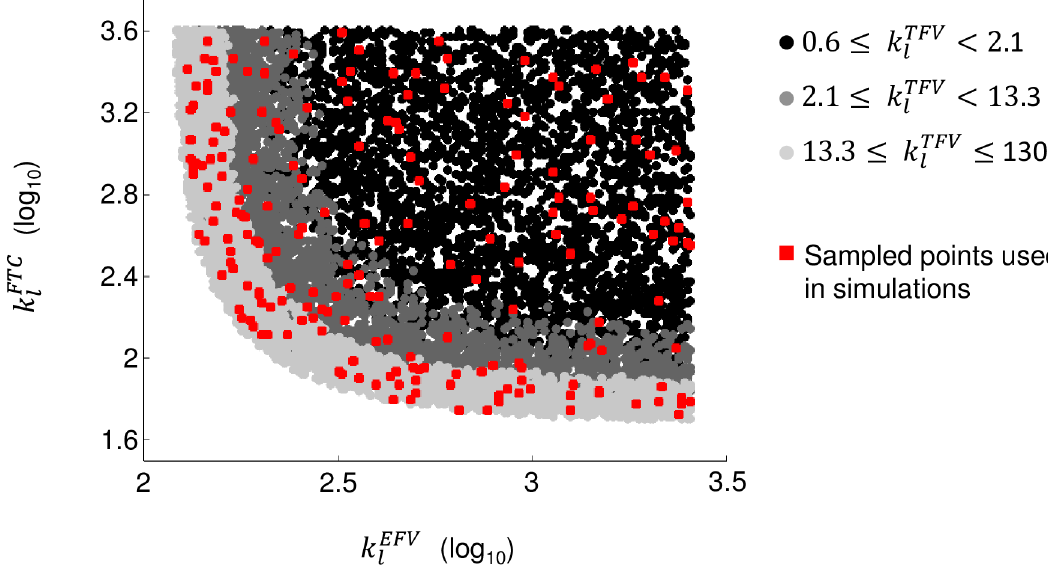
Fig 4. Space of k l parameter values associated with efavirenz (EFV), tenofovir (TFV) and emtricitabine (FTC) leading to an inhibition of 55%-65% of infection events in the drug-limited compartment. Parameter k inside peripheral blood mononuclear cells to its equivalent in the hypothesized drug-limited